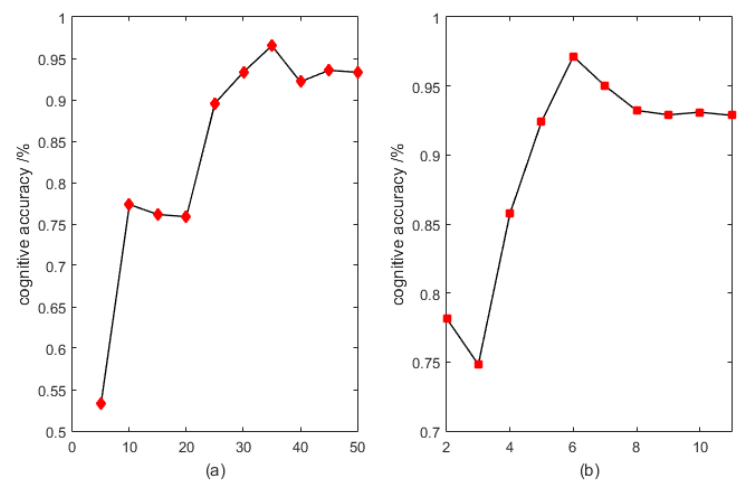
Figure 5. Cognitive accuracy vs. parameters of bagging SCN classifier: ( a ) performance with various L values and ( b ) performance with various n h values.